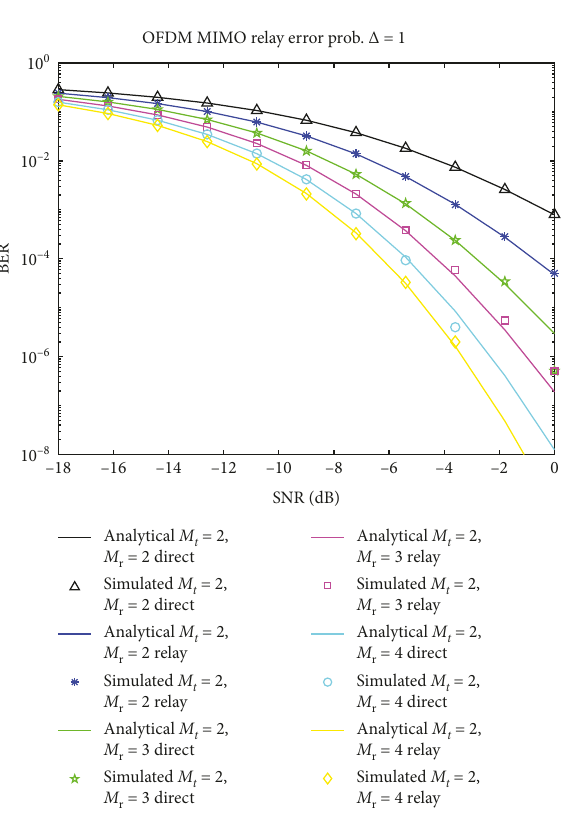
Figure 8: BER performance with MIMO-OFDM direct and relay ( Δ �